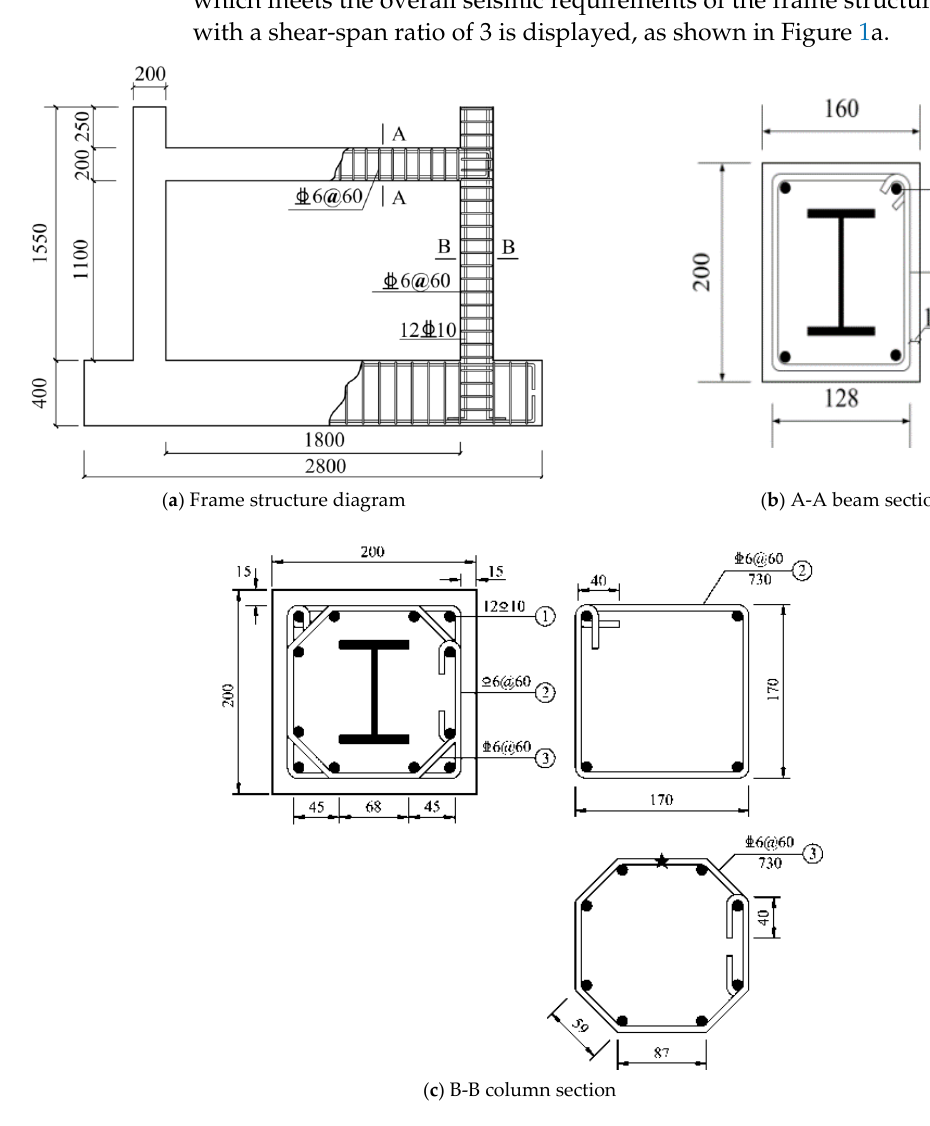
Figure 2. The construction details of an SRUHSC frame. Table 1. Design parameters of the specimens. Specimens